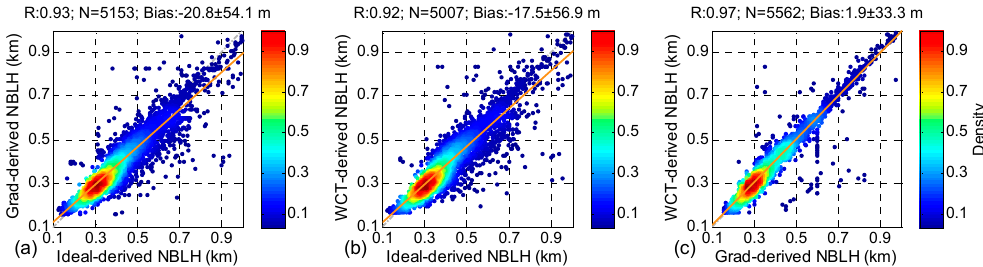
Figure 3. Comparison of LiDAR-derived ABLHs derived through different approaches from RCS: ( a ) the ideal profile-fitting method versus the gradient method; ( b ) the ideal profile-fitting method versus the wavelet covariance transform method; and ( c ) the gradient method versus thre wavelet covariance transform method.